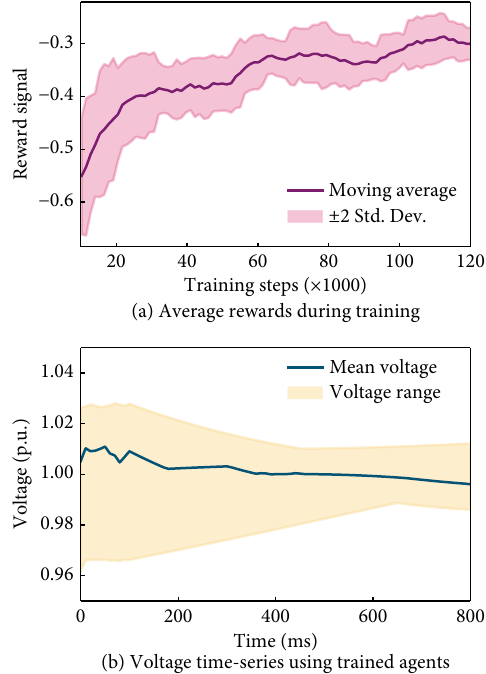
Fig. 8 Sample results from Case